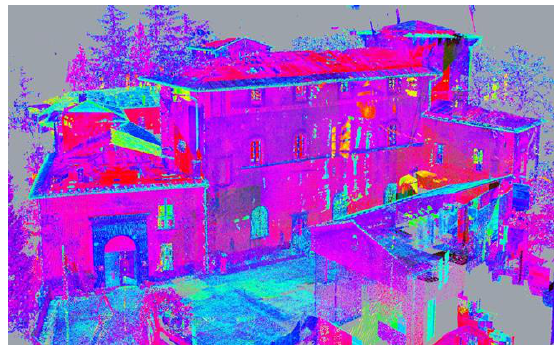
Fig. 3. A visualization of the point cloud after scan registration (176 scans, 7.5 billion